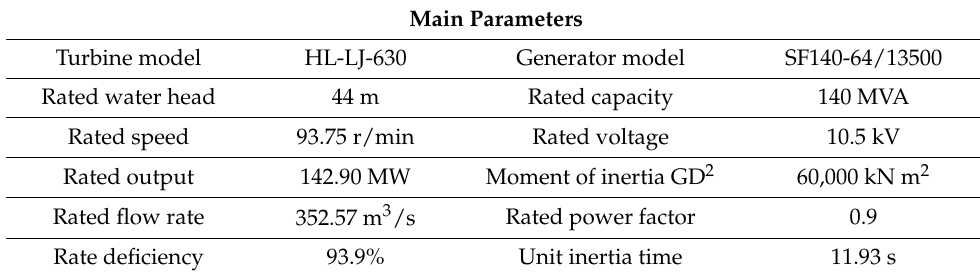
Table 1. Main Parameters of Hydropower Unit.